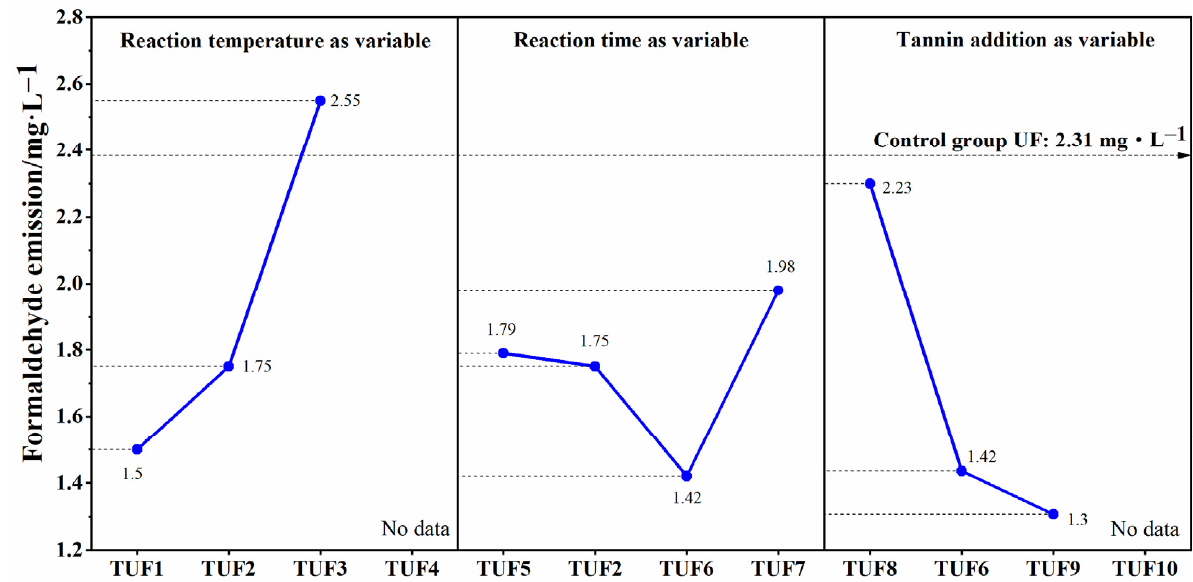
Figure 10. Formaldehyde emission level from the different prepared resins.